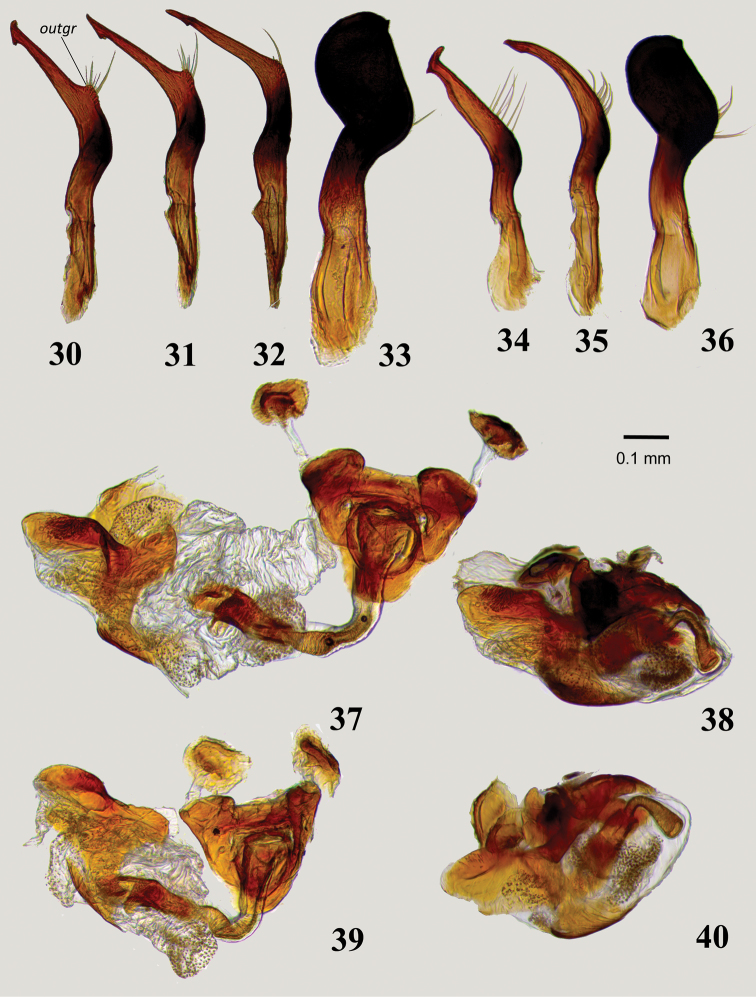
Male genitalia: 30–32, 34–35 Left paramere in lateral (30, 34) and dorsal (31, 32, 35) views 30–32Myrmecophyesarmeniacus Drapolyuk, 1989 34, 35Myrmecophyesheterocerus Horváth, 1927 33, 36 Right paramere in dorsal view 33M.armeniacus36M.heterocerus37–40 Aedeagus in lateral view (38, 40) and with phallotheca detached from phallobase and partially expanded endosoma (37, 39) 37, 38M.armeniacus39, 40M.heterocerus. Abbreviations: outgr – rounded outgrowth at base of apical process of the left paramere.